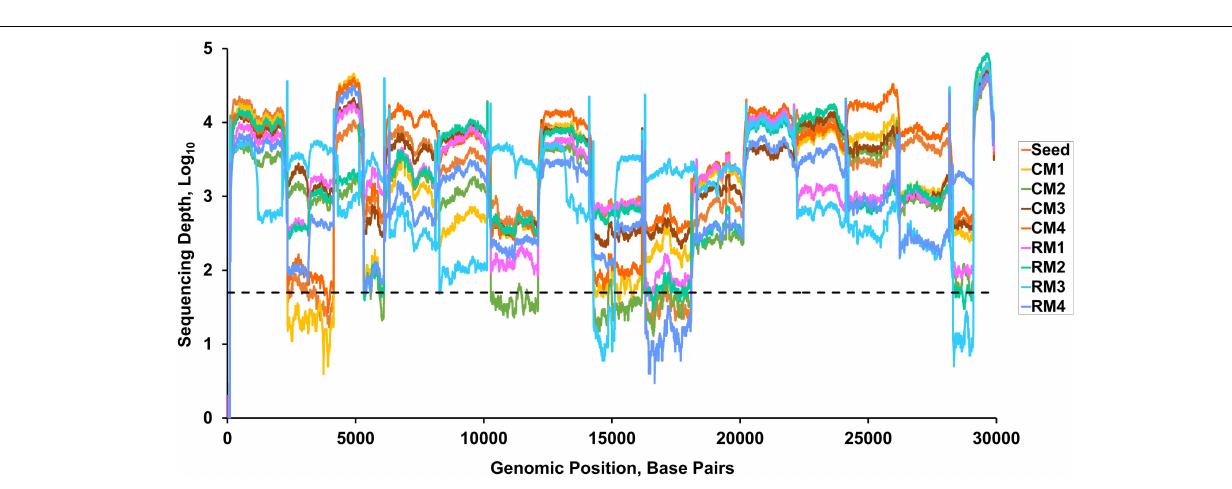
or stop mutations (1/24, 4.2%). The rate of non-synonymous mutations was highest in ORF3a (4/4, 100%), followed by S (5/6, 83.3%) and ORF1ab (9/13, 69.2%). The stop codon was only observed in the N